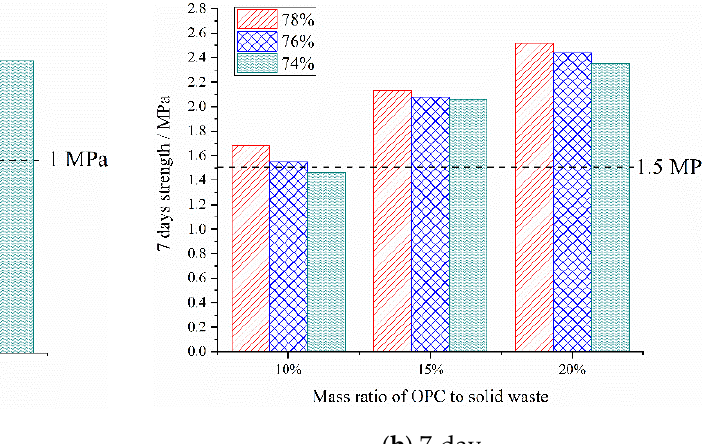
Figure 9. Early-strength test results of backfill